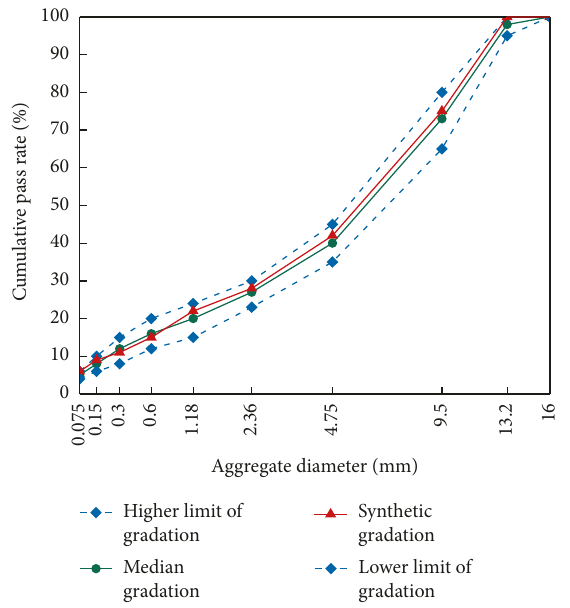
Figure 3: Synthetic gradation diagram of AC-13 asphalt mixture. Figure 4: Synthetic gradation diagram of SMA-13 asphalt mixture.